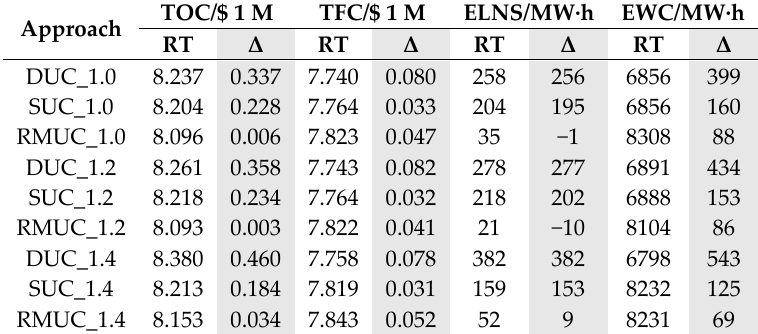
Table 1. Economic performance results of three approaches.